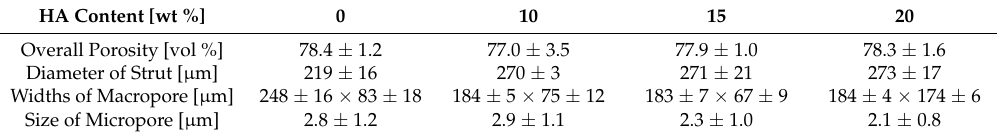
Table 1. The porous structure (overall porosity, diameter of strut, widths of macropore, and size of micropore) of the macro/micro-porous PCL/HA composite scaffolds produced with various HA